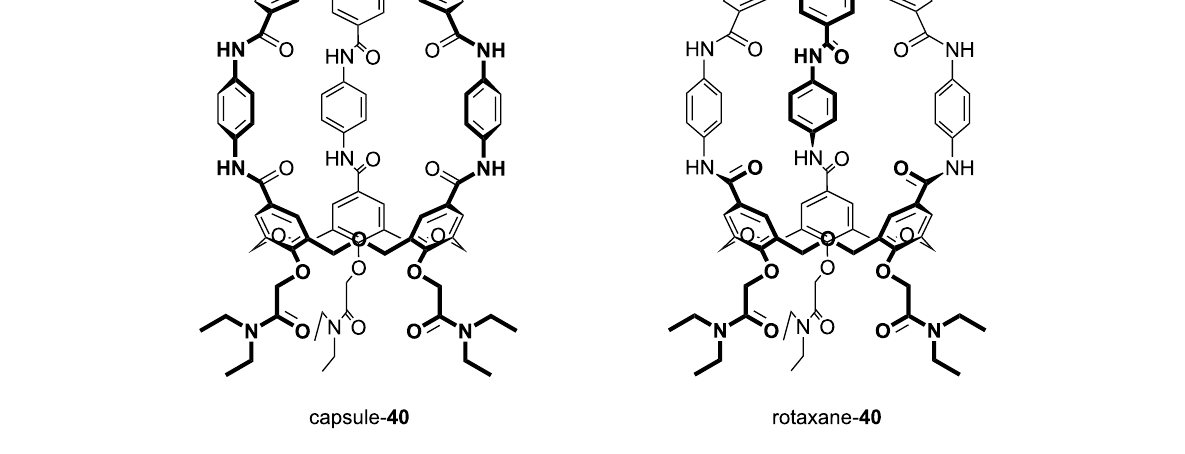
Figure 13: Two forms of dimeric oxacalix[3]arene 40 [47].